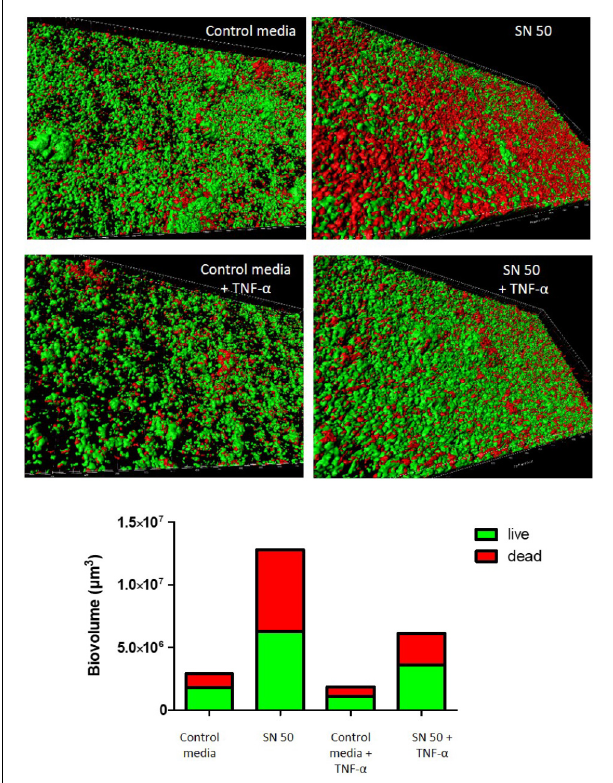
FIGURE 7 | Dynamic model confirmed the impact of osteoblast culture supernatants on S. aureus biofilm formation. Impact of osteoblast culture on biofilm was tested into the flow-through medium of the flow cell apparatus for 24 h. Each panel shows 3D reconstruction by Imaris software after acquisition in confocal microscopy with live (green color)/dead (red color) staining. Bottom panel represents the quantitative data calculated Imaris software based on acquired images. Control media, 50% DMEM + 10% FCS and 50% of minimal media; SN 50, culture with 50% of osteoblast culture supernatants and 50% of minimal media; Control media + TNF- α = 50% DMEM, 10% FCS, 20 ng/ml TNF- α , 50% minimal media; SN 50+TNF- α , culture with 50% of osteoblast culture supernatants exposed to 20 ng/ml of TNF- α and 50% of minimal